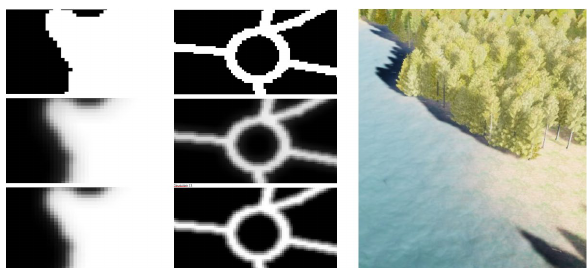
Figure 2. Results of convolution filters on the landscape masks (Left, Middle). Result of convolution on landscape masks, Unreal Engine vegetation generated through the Procedural Foliage Generator (Right)